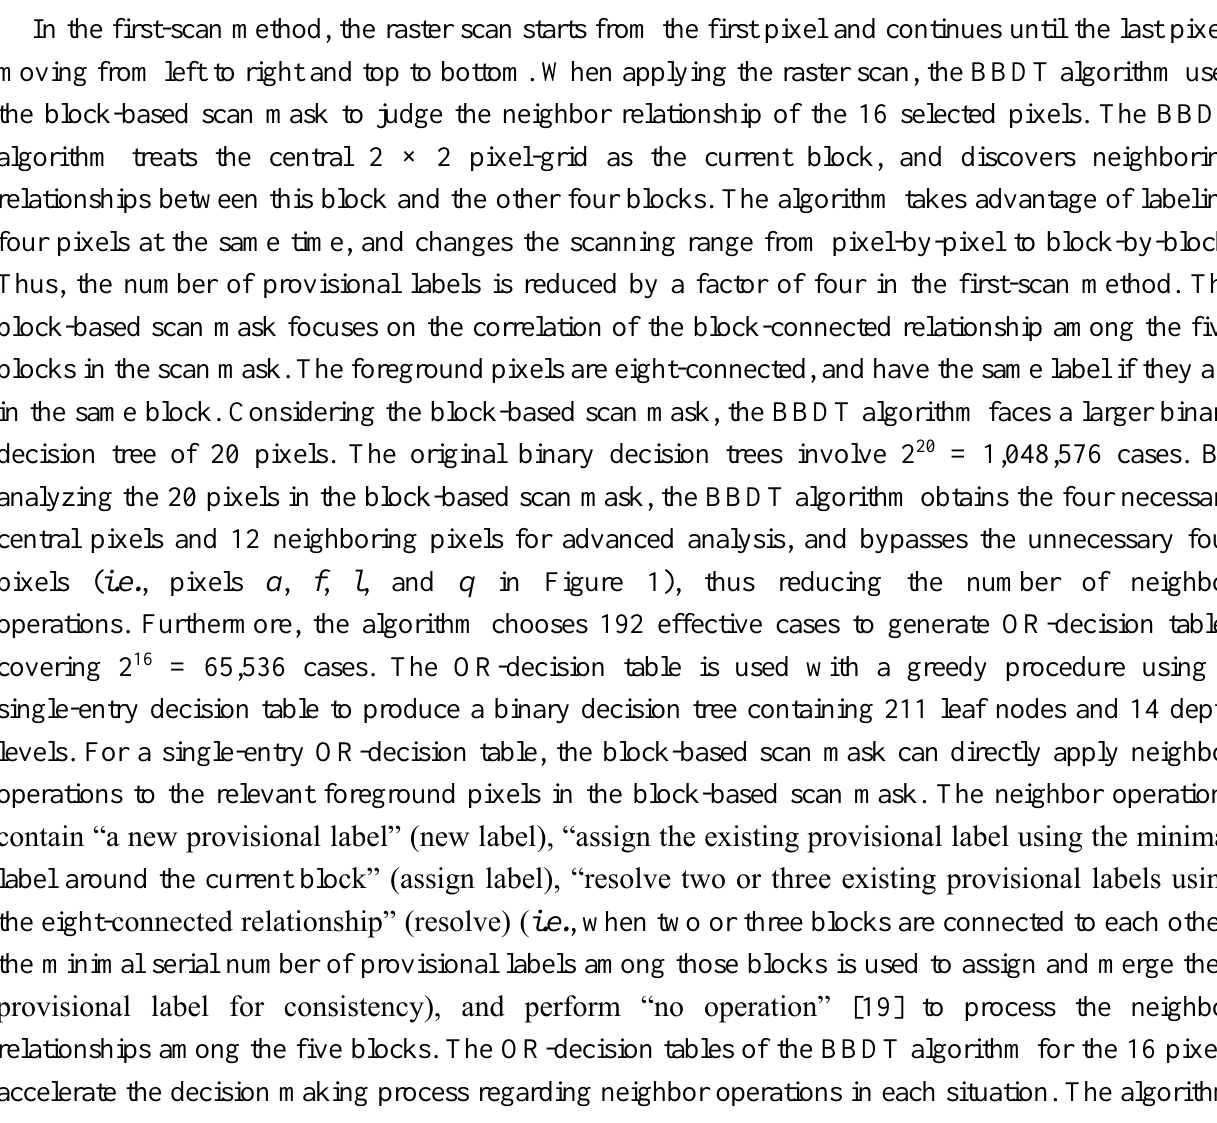
Figure 1. Relative locations of pixels in the block-based scan